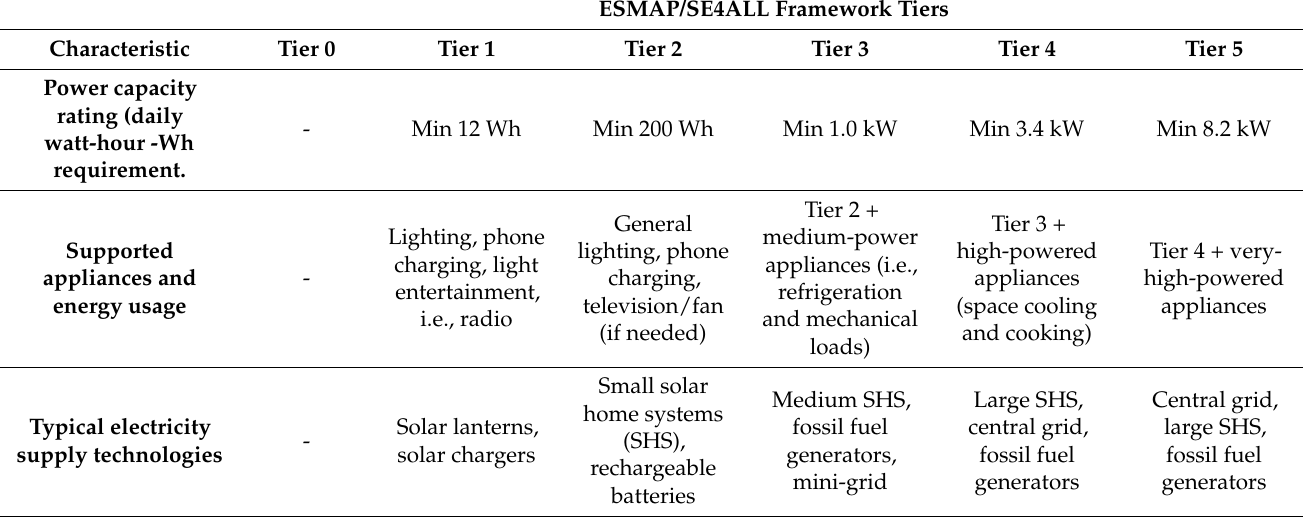
Table 7. Multi-tier energy framework to measure access to household electricity supply (adapted from